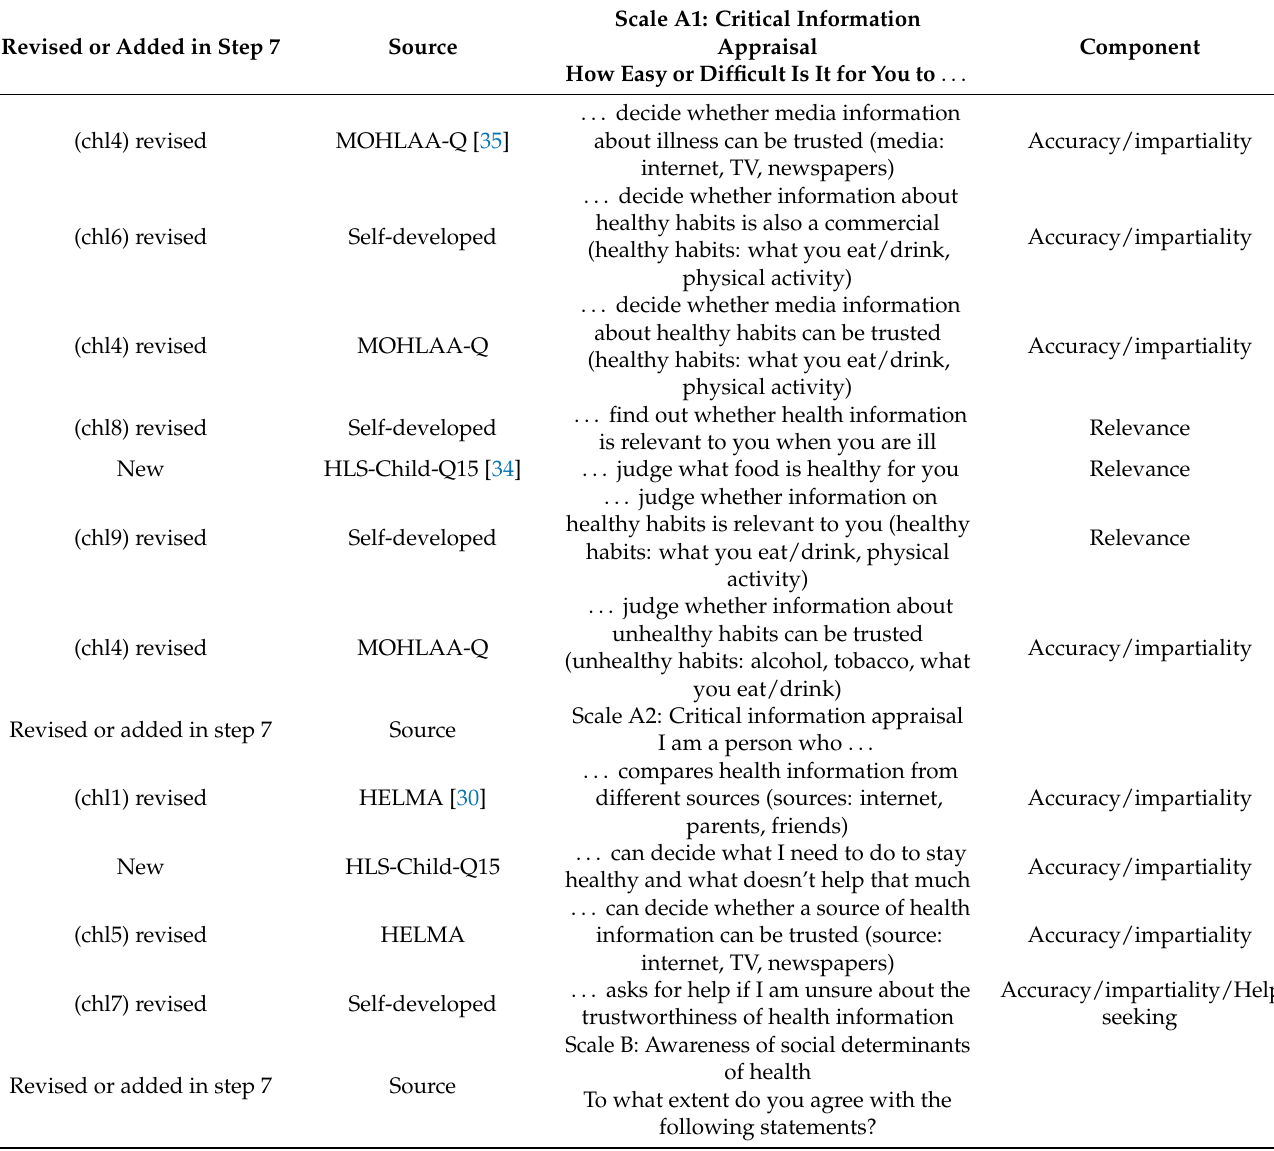
Table 4. Revised items and scales of the